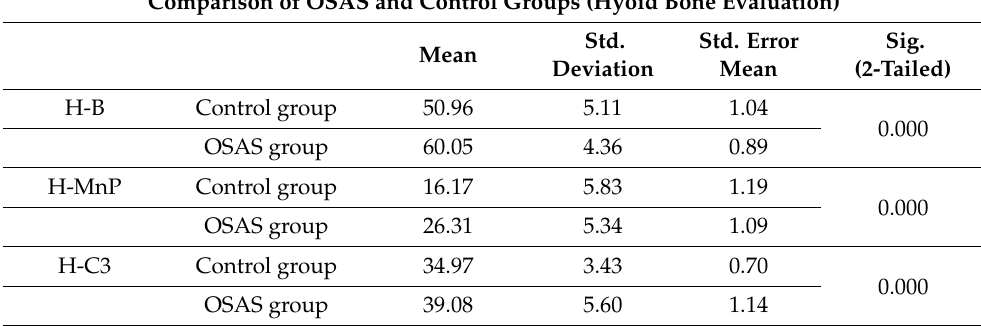
Table 5. The comparison of the hyoid evaluations of the OSAS group and control group. Comparison of OSAS and Control Groups (Hyoid Bone Evaluation) Std. Std. Error Mean Deviation Mean